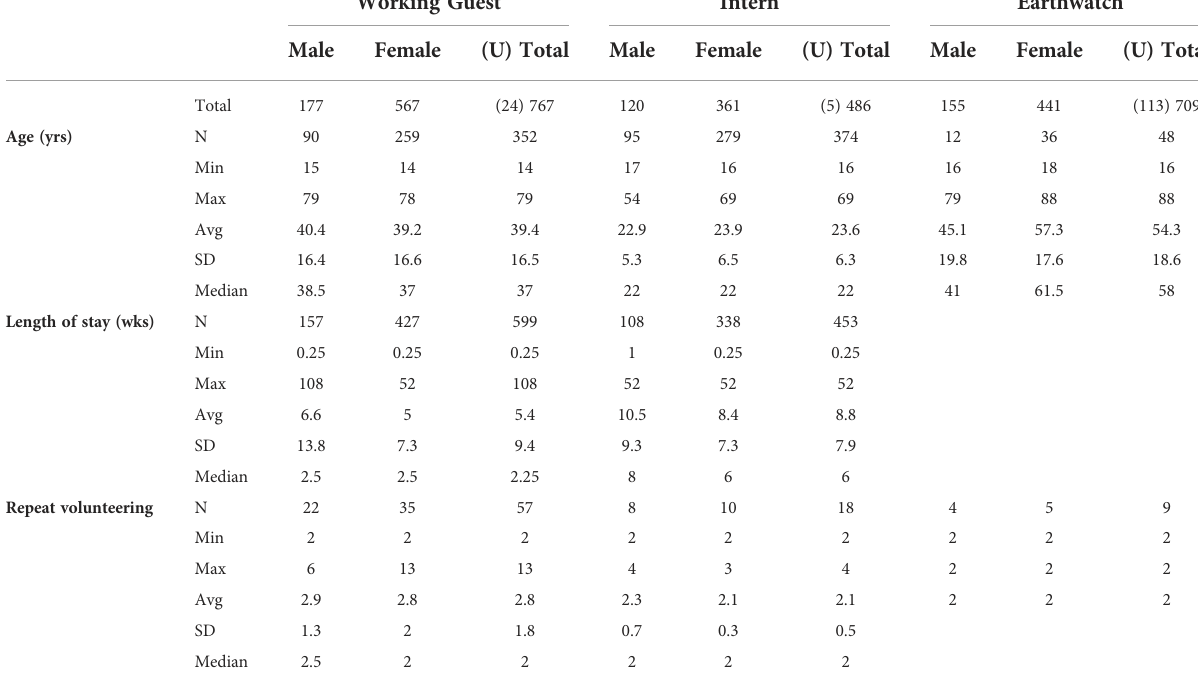
TABLE 1 Overview of CCF ’ s volunteers expanding 31 years including volunteer age and length of volunteering. Working Guest